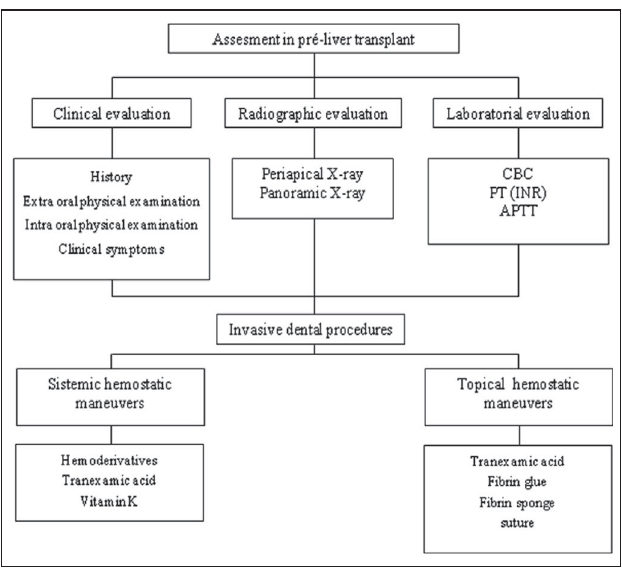
Fig. 1. Algorithm criteria for dental care to patients scheduled for liver